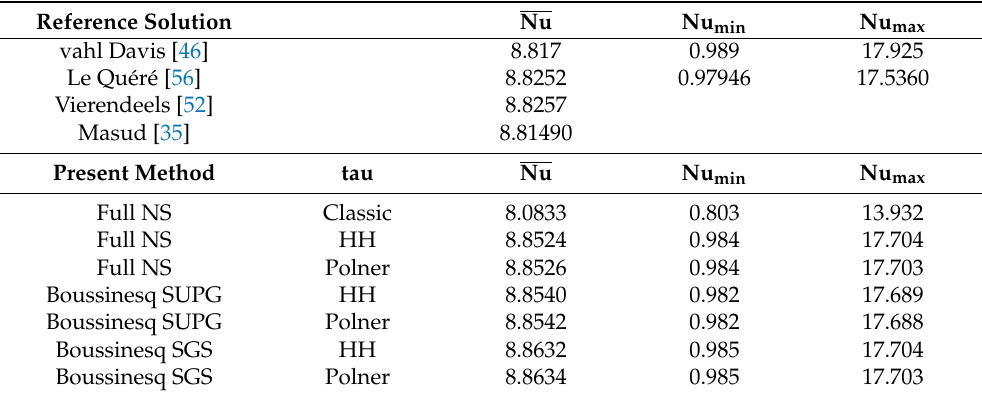
Table 2. Nusselt numbers along hot vertical wall. Ra = 10 6 , (cid:101) = 0.01, constant µ . Present methods on a 140 × 140 uniform mesh with various taus.